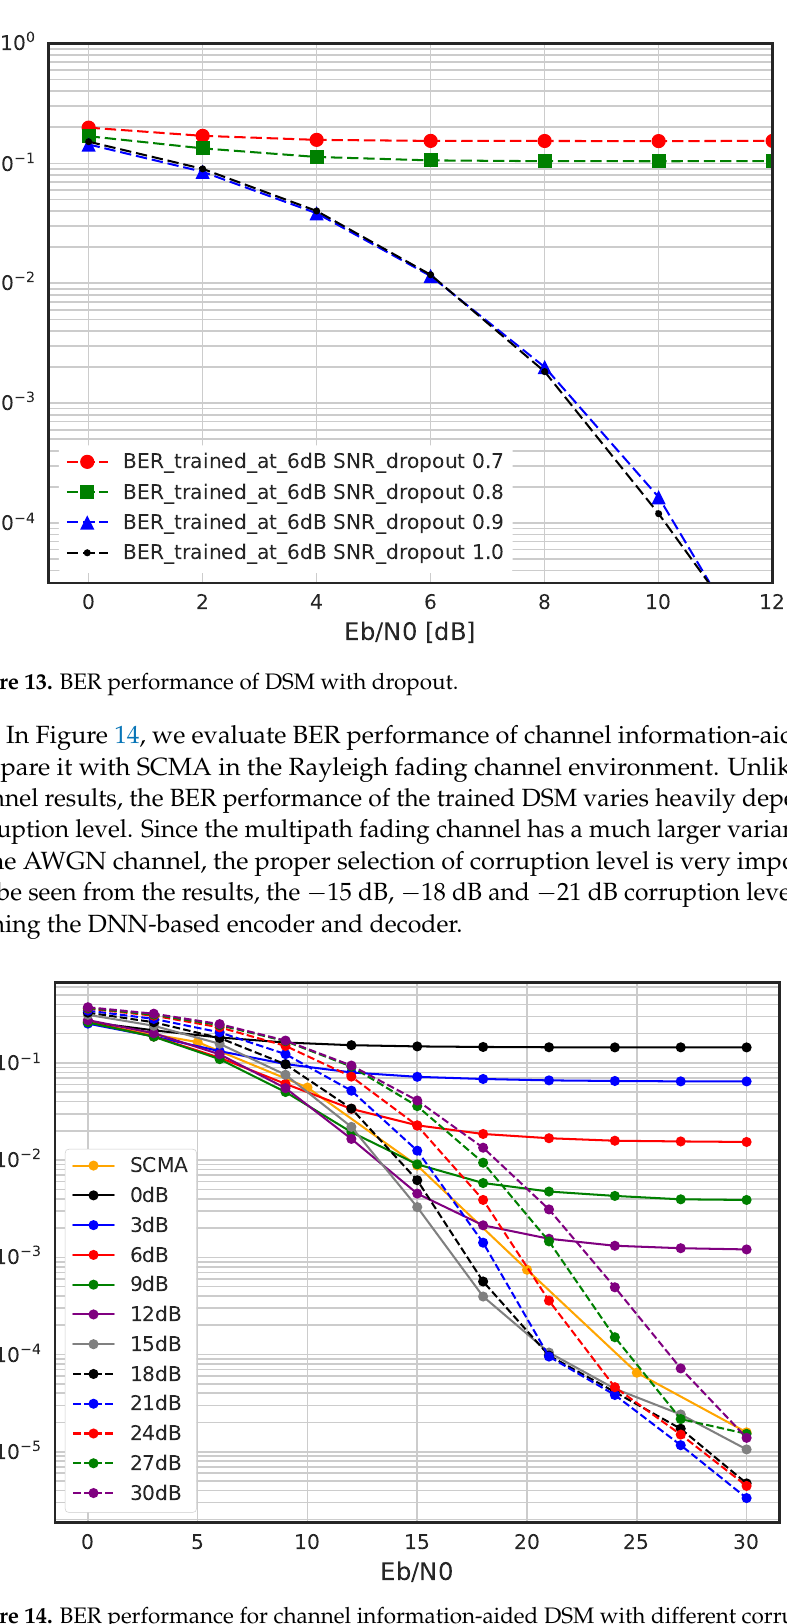
Figure 14. BER performance for channel information-aided DSM with different corruption